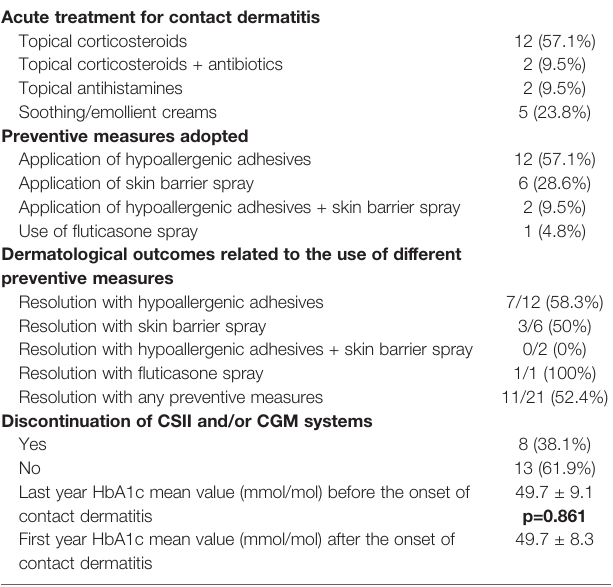
TABLE 3 | Therapeutic and preventive measures for the management of contact dermatitis and clinical outcomes. Acute treatment for contact dermatitis Topical